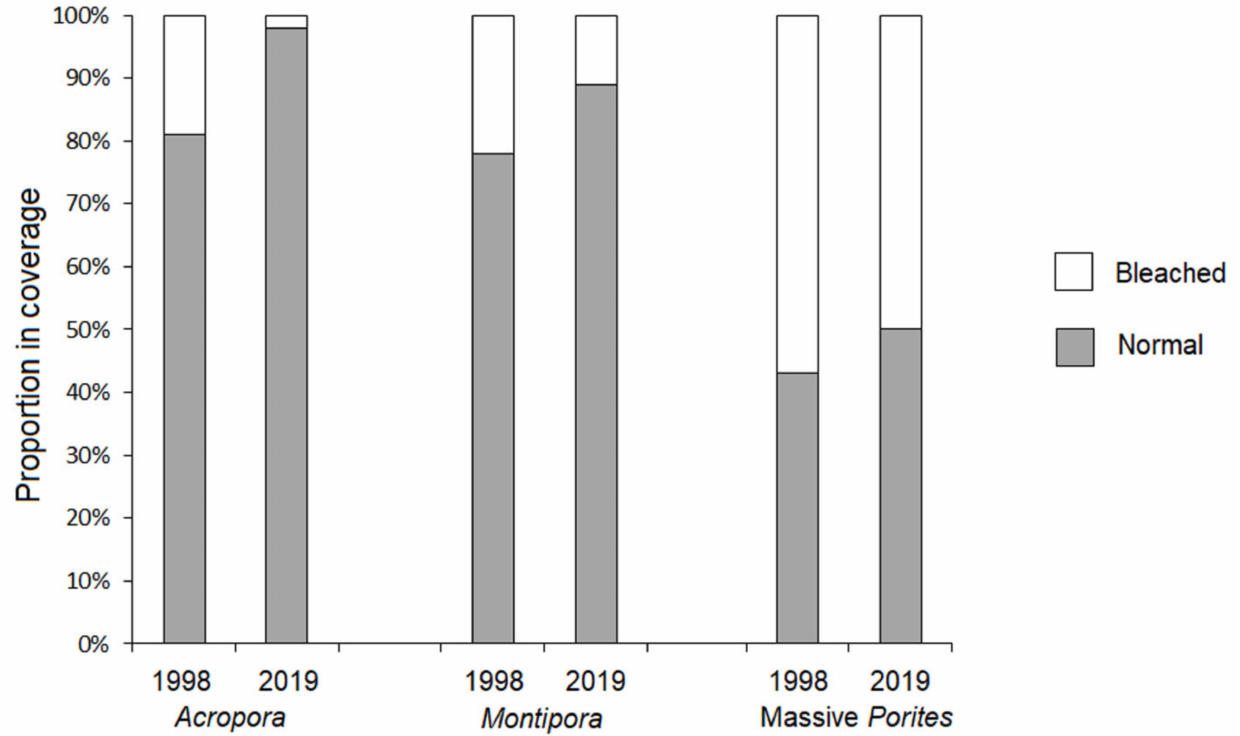
Figure 7. Variations in proportion of bleached vs. normal coral colonies of the dominant coral taxa of the CDNP during 1998 and 2019 ENSO-related thermal anomalies (based on data presented in